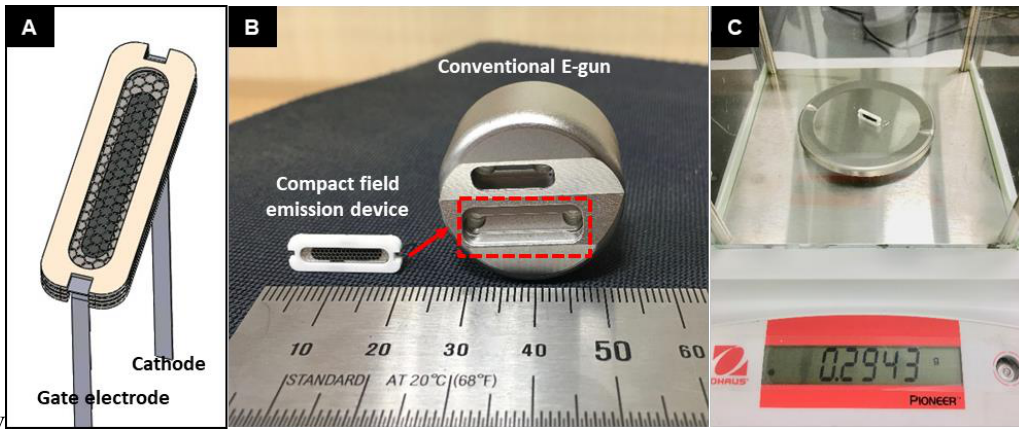
Figure 2. ( A ) 3D design of compact field emission device embedded with directly grown CNT on metal substrate; ( B ) photo image of compact field emission device and conventional dual type electron gun after removing filament emitter; ( C ) photo image of 0.2943 gram-weight of compact field emission device.